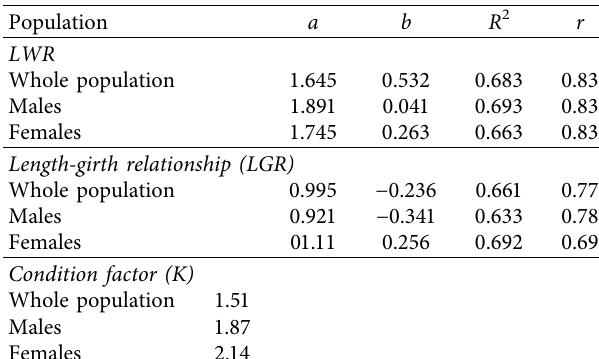
Table 2: Linear relationship of morphometric parameters of Heterotis niloticus